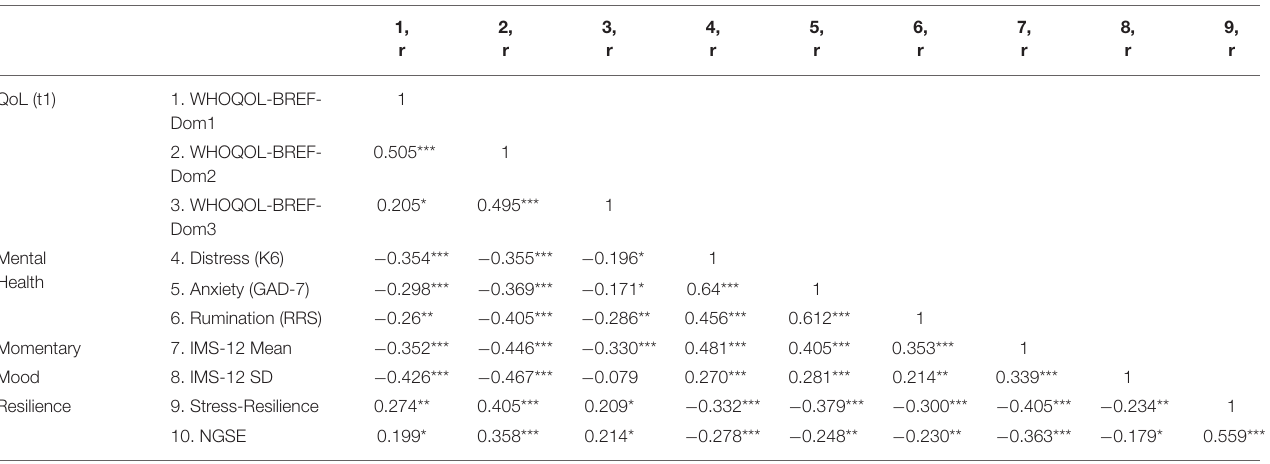
TABLE 2 | Pearson correlational analysis of the relationships between study variables.